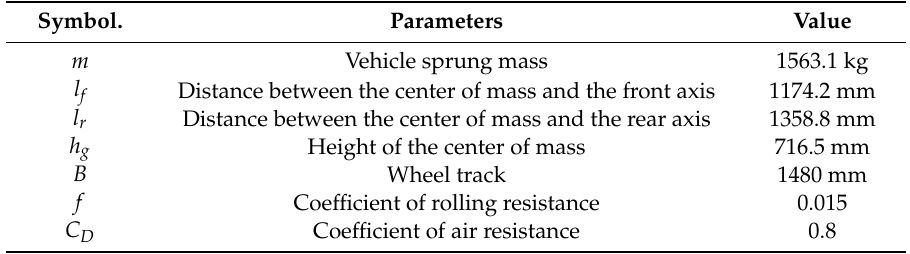
Table 1. Basic parameters of the vehicle dynamics model.